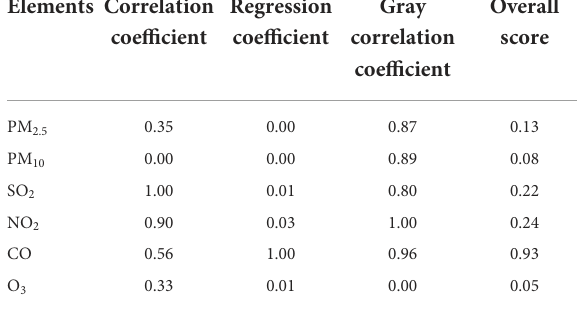
TABLE 4 The overall score for each index obtained using the entropy weighting